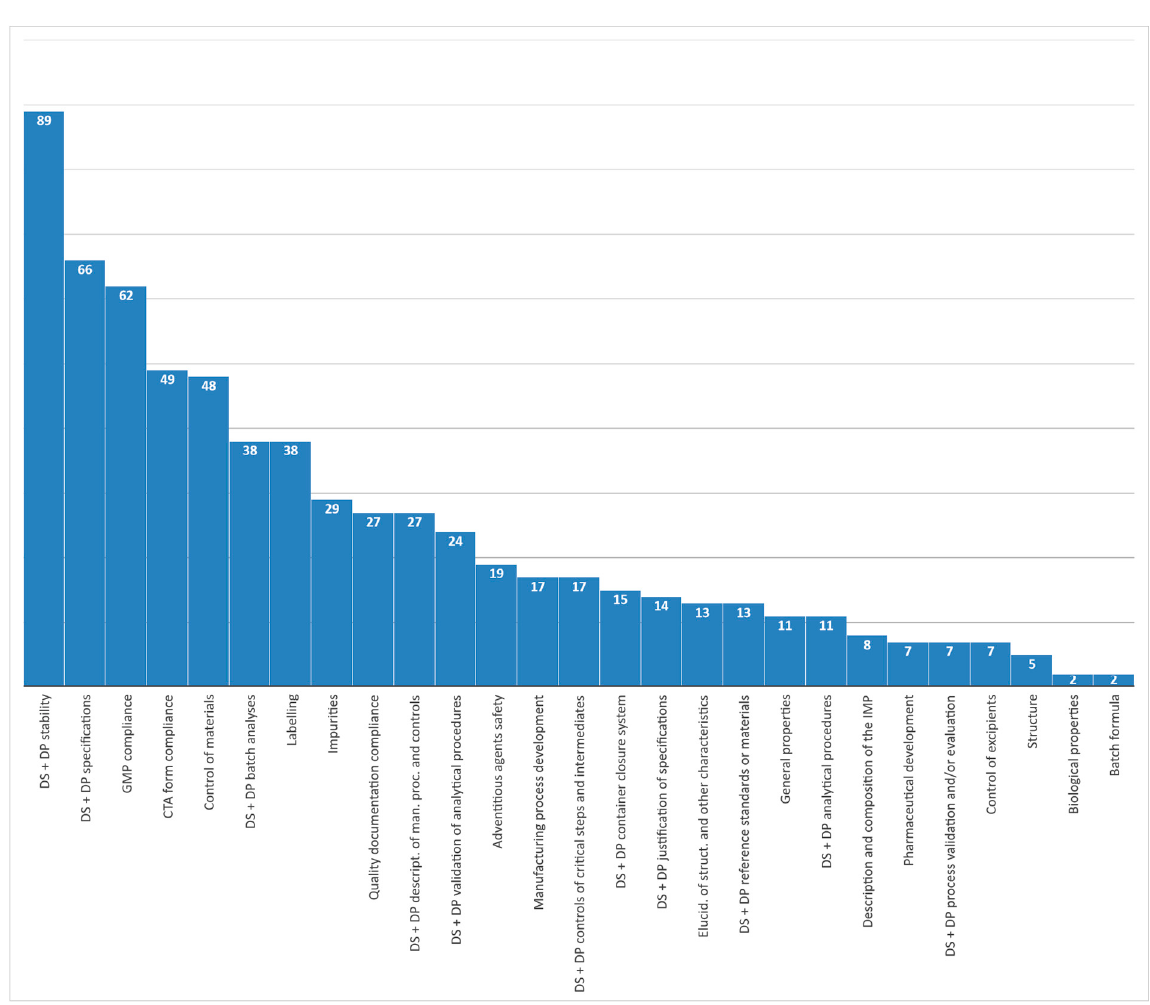
Figure 5. Number of quality issues combining drug substance (DS) and drug product (DP) classification label in COVID-19 CTs assessed from March 2020 to March 2021.